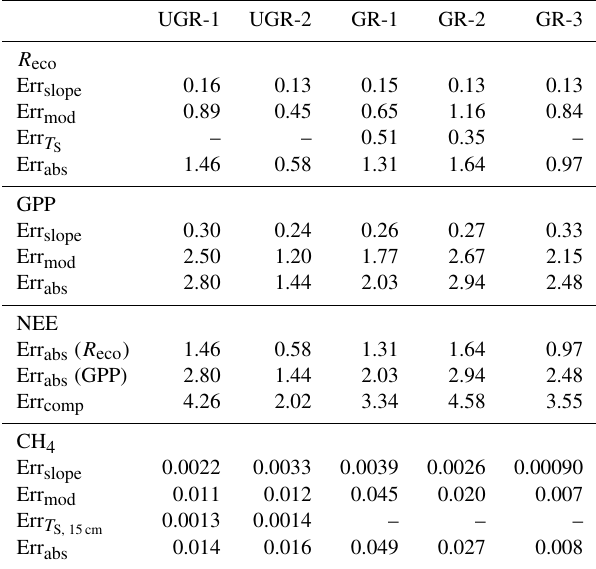
Table B4. Error range of C fluxes, with values given in µmolCm − 2 s − 1 . Err abs describes the final cumulative error that is also used in the results